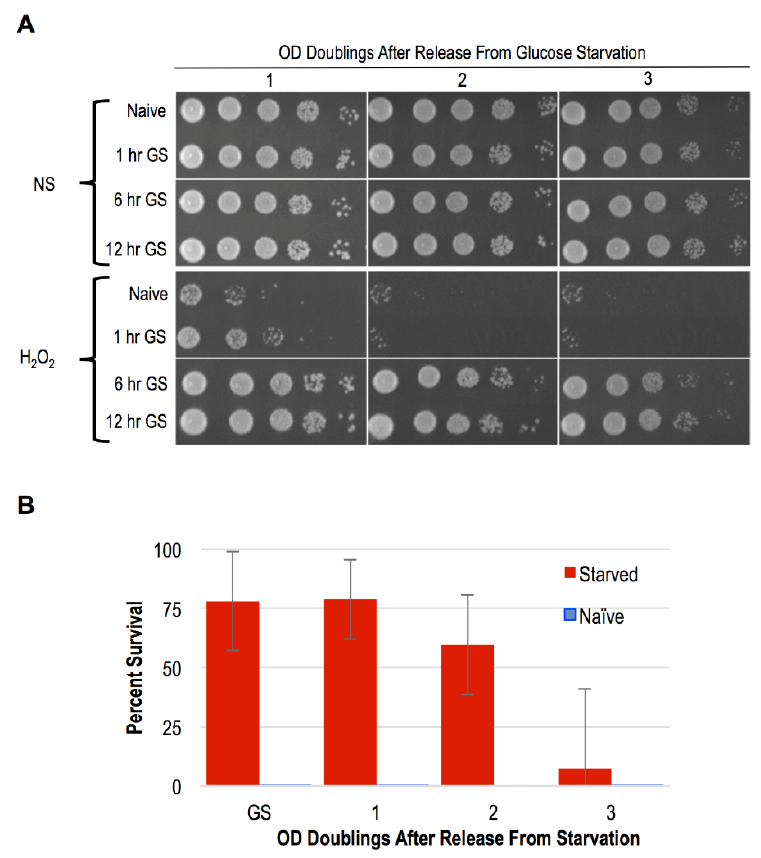
FIGURE 4: Cellular memory of glucose starved cells. (A) Cells grown to log phase in YPD media were harvested and incubated in YP media lacking glucose for varied times. Following glucose with- drawal, cells were subjected to H 2 O 2 stress and survival was assayed using spotting assays. (B) Survival of cells released from glucose starvation and exposed to H 2 O 2 was quantified. Error bars represent 1 standard error of the mean from 3 biological